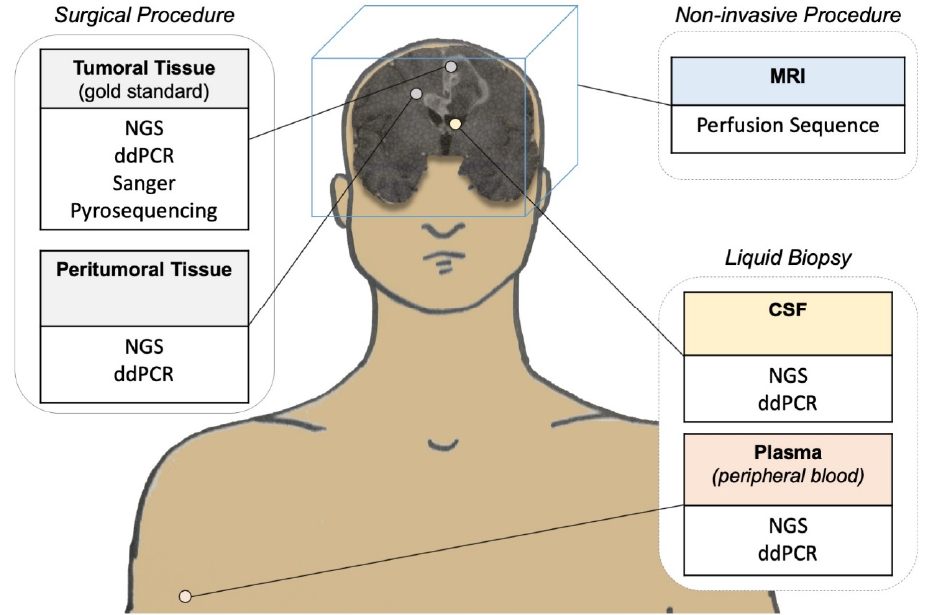
Figure 2. Methods to detect TERTp alterations in patients with glioblastoma. The current reference method is the detection of alterations based on sequencing techniques applied to tumor tissue obtained from either lesion resection or from targeted biopsy in cases of non-resectable tumors. The other methods, particularly noninvasive or minimally invasive methods, are still under development and are not yet used in routine clinical practice.